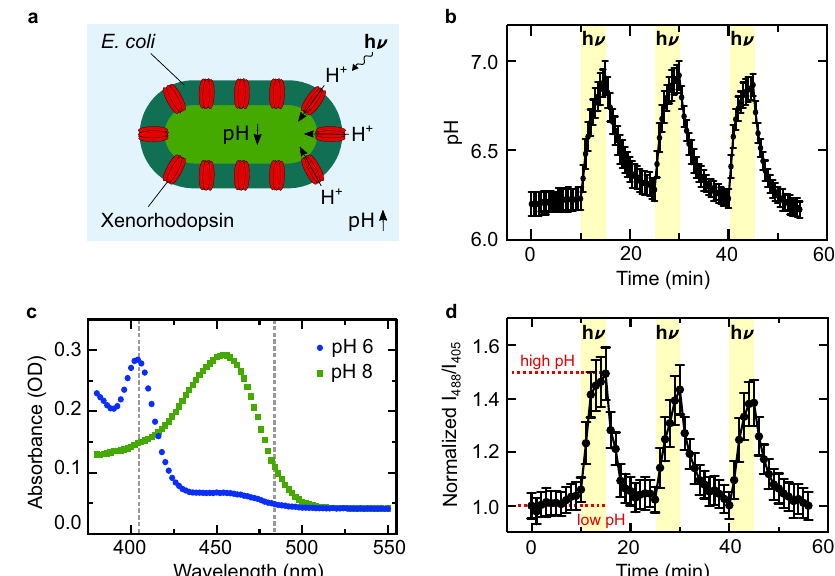
Fig. 1 Genetically engineered xenorhodopsin-expressing E. coli generate a pH gradient upon illumination with white light. a Schematic illustration of an E. coli expressing xenorhodopsin, a light-driven proton pump (red), allowing for the reversible generation of a directional pH gradient during illumination with white light. The inward pump increases the pH of the external solution. b Photoactivity generated by the E. coli (OD 600 = 20, in 150 mM NaCl) measured with an external pH electrode. The pH is plotted over time during three light-dark cycles (periods of illumination are indicated in yellow). The pH increases by almost one pH unit within 5 min of illumination and nearly returns to its original value after 10 min in the dark (mean± s.d., n = 3). c Absorbance measurements of the pH-sensitive ratiometric fl uorophore pyranine at pH 6 (blue) and pH 8 (green). The pH can be quanti fi ed as the fl uorescence intensity ratio at the excitation wavelengths 488 nm and 405 nm (gray dashed lines). d Normalized fl uorescence intensity ratio I pyranine (50 μ M) over time in a solution containing E. coli and lipid vesicles as determined with confocal fl uorescence microscopy (mean ± s.d., n = 4). Periods of illumination are indicated in yellow. Source data is available for Fig. 1b –